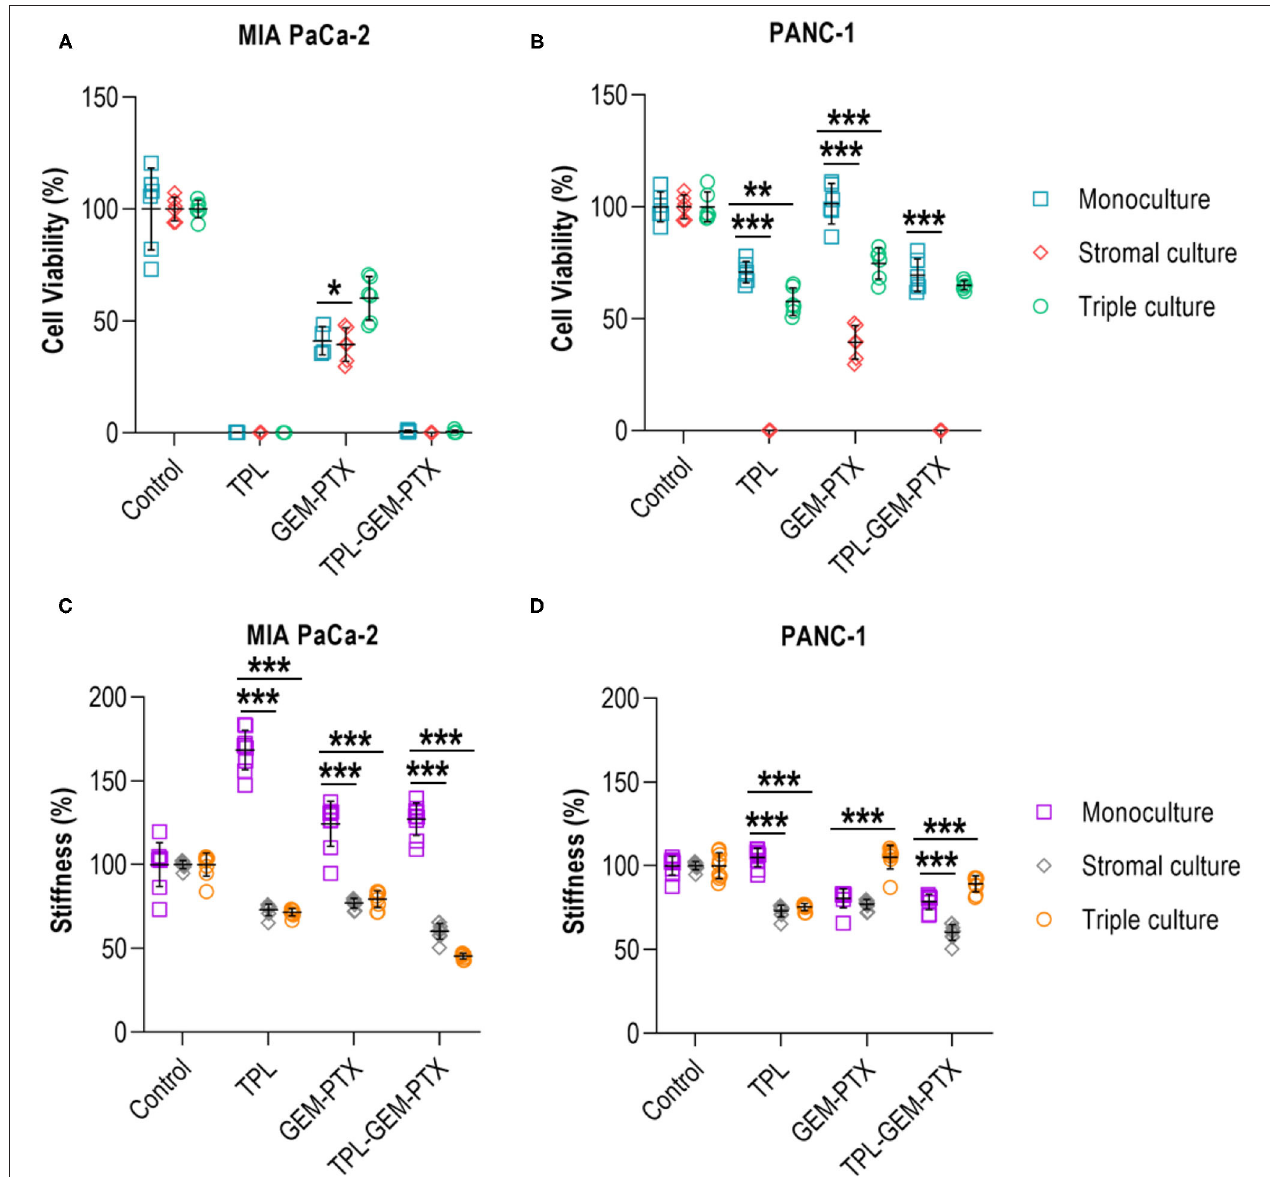
FIGURE 6 | Treatment of multicellular 3D cultures. (A) Triptolide treatment was effective in reducing the cell viability of MIA PaCa-2 monoculture, stromal and triple cultures. No additive effect was achieved by combining triptolide with gemcitabine and paclitaxel. (B) PANC-1 monoculture and triple culture had a decreased cell viability by 30-40% when exposed to triptolide and in combination with gemcitabine and paclitaxel. (C) Treatment with triptolide, gemcitabine, and paclitaxel increased the mechanical properties of MIA PaCa-2 cell monocultures but reduced the mechanical properties of stromal and triple cultures. (D) PANC-1 cell monocultures and stromal cultures had reduced mechanical properties upon gemcitabine and paclitaxel treatment, whereas triple cultures showed a reduction of the mechanical properties upon triptolide exposure. Cells were treated with triptolide for 3 days, followed by gemcitabine and paclitaxel for 4 days. Results shown represent independent experiments performed in triplicates ( n = 3, error bars = SD; ** = p ≤ 0.01; *** = p ≤ 0.001). TPL, triptolide; GEM-PTX, gemcitabine-paclitaxel; TPL-GEM-PTX,